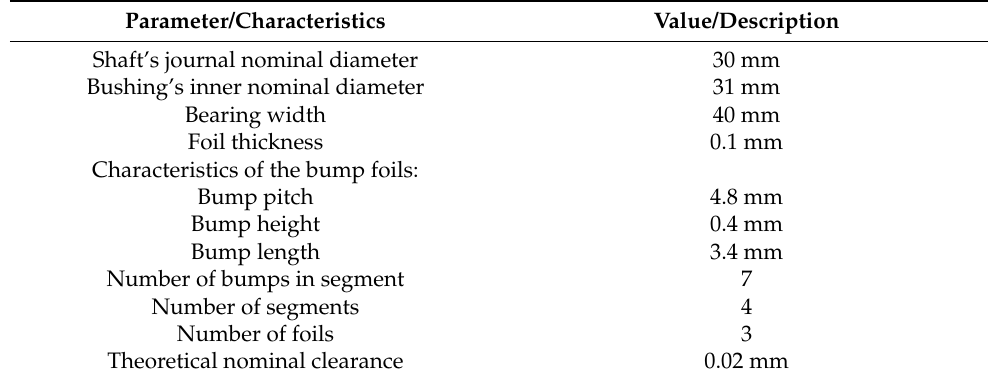
Figure 4. Assembled prototype GFB’s bushing (on the left) and sensing top foil before installation in the bearing (on the right). The integrated thermocouples and strain gauges are visible through the openings in the spool-shaped tierces of the GFB’s bushing that were machined to allow radial guidance of the sensors’ cabling. On the sensing top foil, there were visible spots caused by the gluing process of the strain gauges. However, the excessive amount of glue was removed from the area of contact between the top and bump foils with chemical agents right after completion of gluing process. Effectively, no unexpected behavior of the bearing was indicated due to both the possible change of friction properties and local over-stiffening. Table 1. Geometric characteristics of the tested